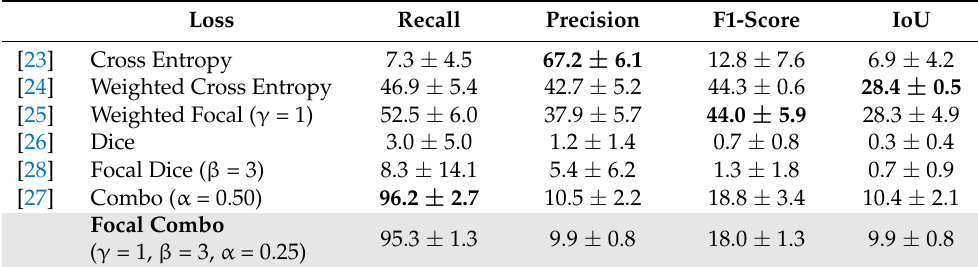
Table 2. Initial results for U-Net in (%) for the road marking class.